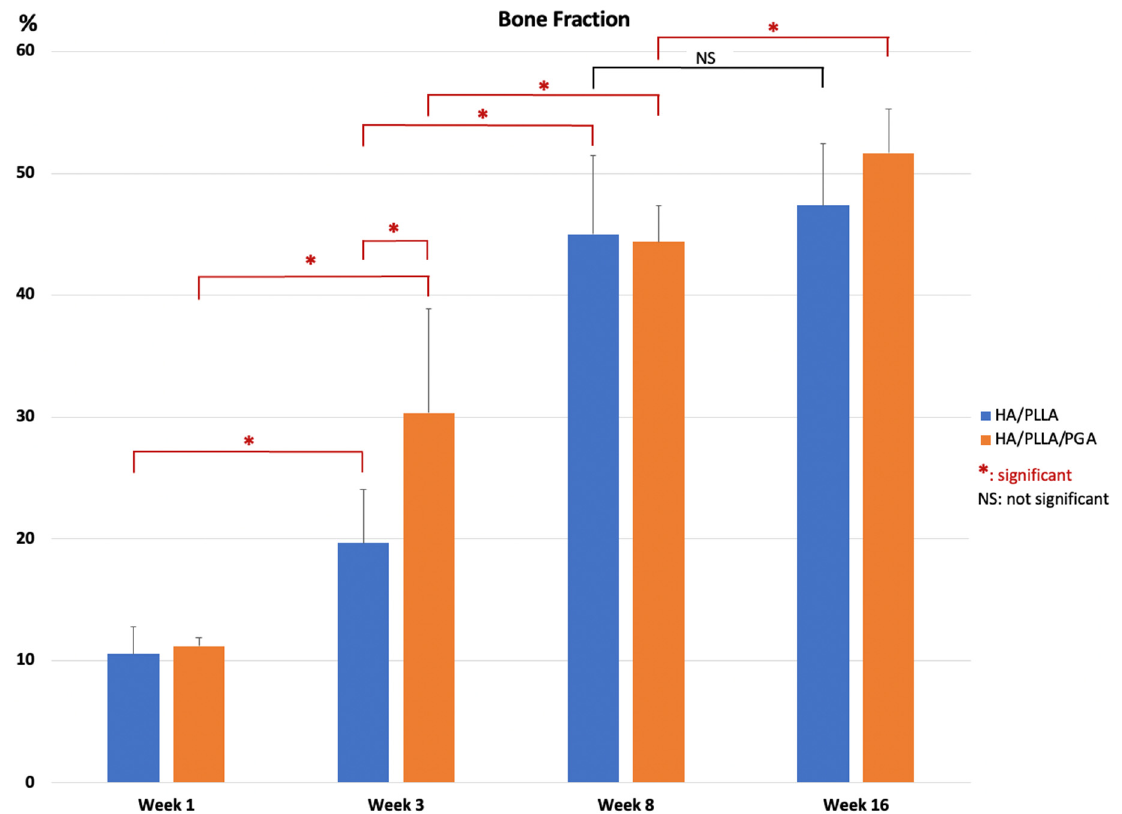
Figure 8. Percentage of new bone volume determined by micro-CT evaluation of u-HA/PLLA and u-HA/PLLA/PGA groups. * p < 0.05.